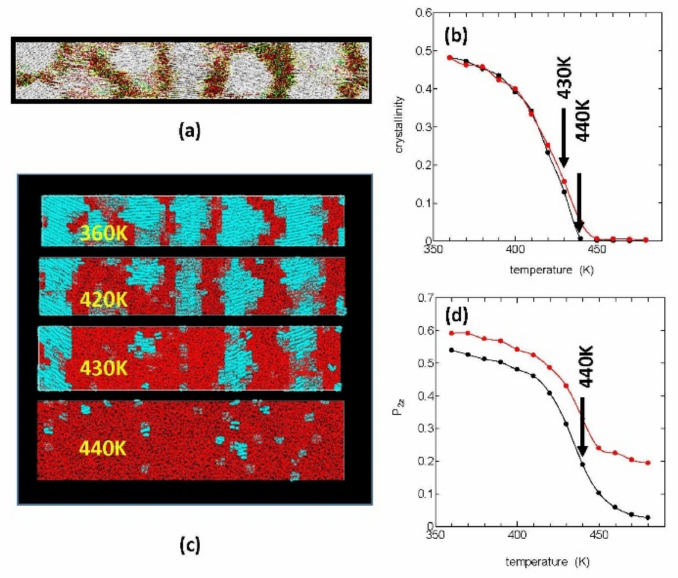
Figure 1. Typical melting process of the oriented stacked lamellae in terms of the crystallinity during heating at a constant rate 10 K/ns. ( a ) The initial crystalline fiber, synthesized in our previous paper. ( b ) The crystallinity is plotted vs. temperature, which shows the clear onset of melting around 440 K. ( c ) Typical melting trajectories of the orientated PE lamellae during the constant heating process at the indicated temperatures; the sample was here placed under stress free condition ( P xx , P yy , P zz ) = (0, 0, 0). The blue and red regions correspond to the crystalline and amorphous regions, respectively. ( d ) The orientational order parameter P 2 z of the C-C-C chord vectors gradually decreasing but remains finite even around the melting